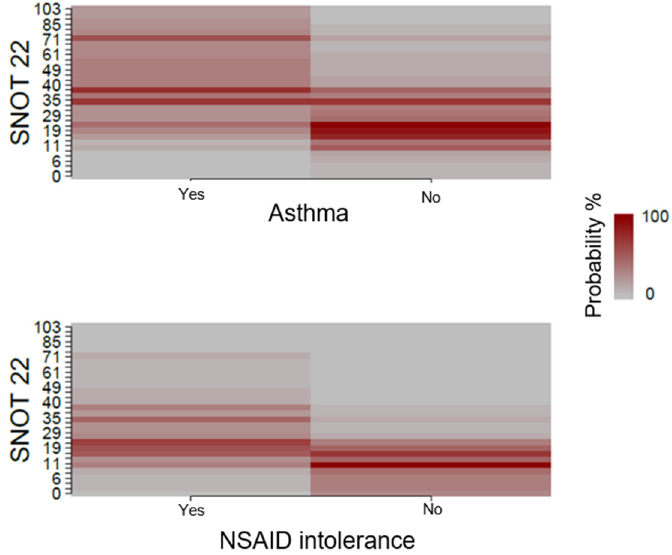
Figure 3. Association between asthma and NSAID intolerance, and QoL measured with SNOT-22.